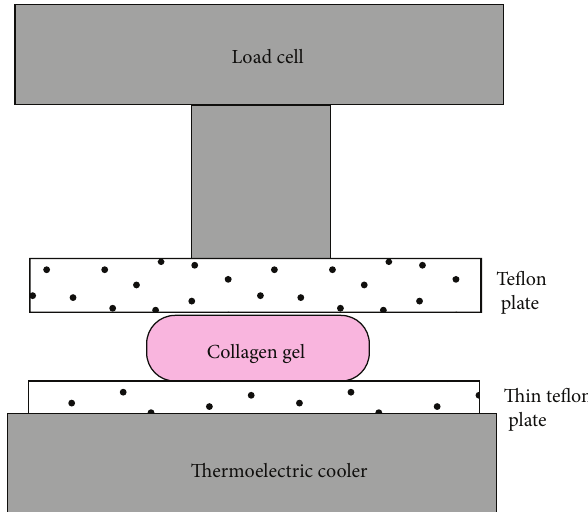
Figure 1: Compression test setup. The teflon plates have a diameter of 70 mm and are attached to a 10 N load cell mounted on an Instron